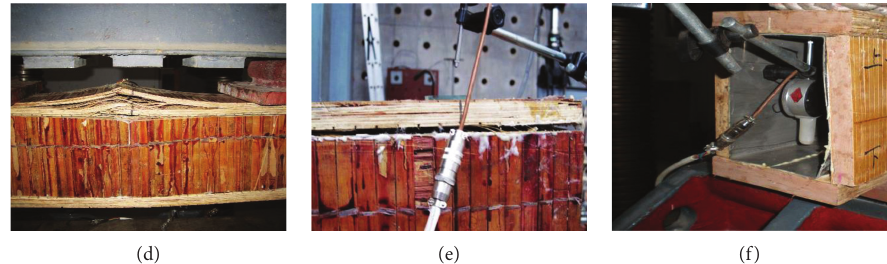
Figure 5: Failure characteristics of composite beams. (a) Extrusion of upper bamboo flange of B-1. (b) Debonding near support of B-2. (c) Extrusion of upper bamboo flange of B-3. (d) Extrusion of upper bamboo flange of B-4. (e) Debonding of B-5. (f) Local buckling near support of B-5.